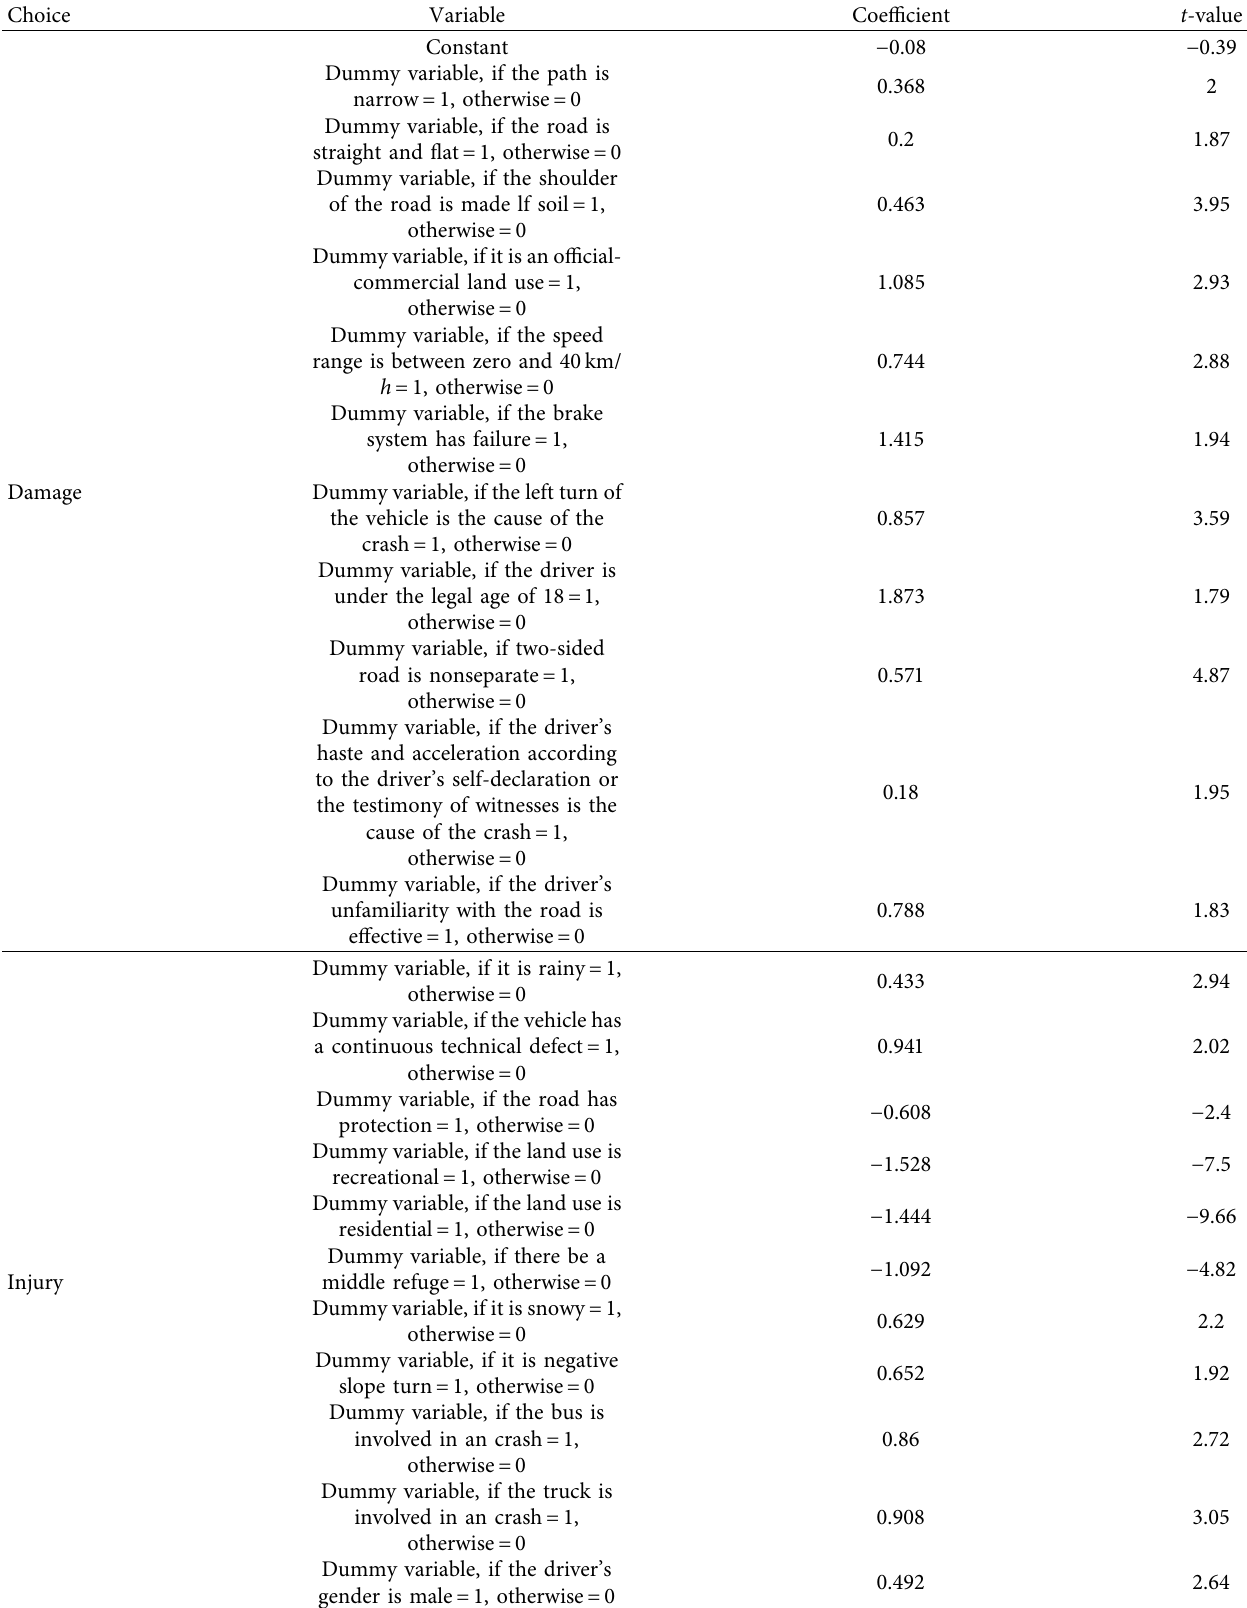
Table 4: Calibration result of multinomial logit